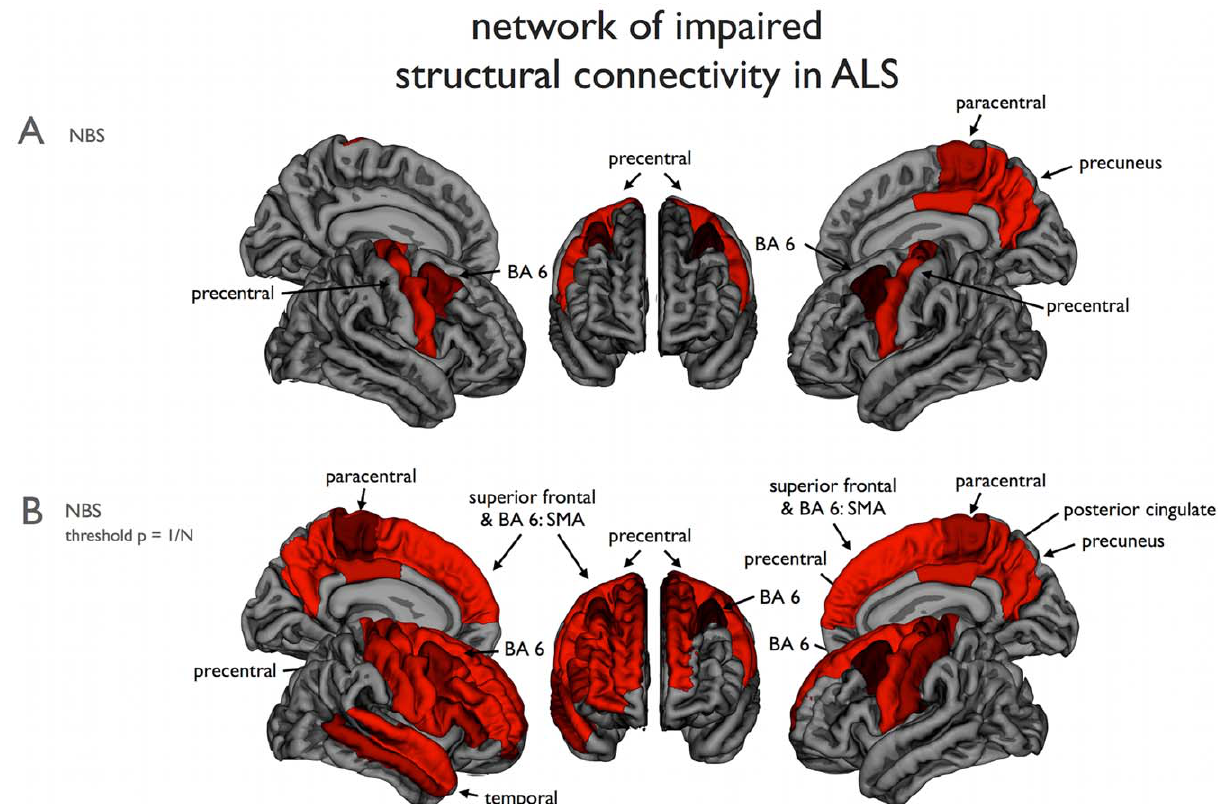
Figure 2. Cortical brain regions with impaired structural connectivity in ALS. (a) The NBS procedure revealed a sub-network of brain regions showing significantly reduced structural connectivity in ALS patients, compared to the healthy controls. Figure shows the set of involved parcellated cortical regions (p=0.0075, see materials and methods). (b) Using an NBS threshold of p=1/N ( N being the number of nodes of the network), a similar but more extended network was revealed. This model-free approach revealed a sub-network consistent with known motor regions, including precentral and paracentral gyri (primary motor), caudal middle frontal and superior frontal gyri (supplemental motor areas, BA6). The subcortical structures found with the NBS procedure were not included in this figure. Right=Right;